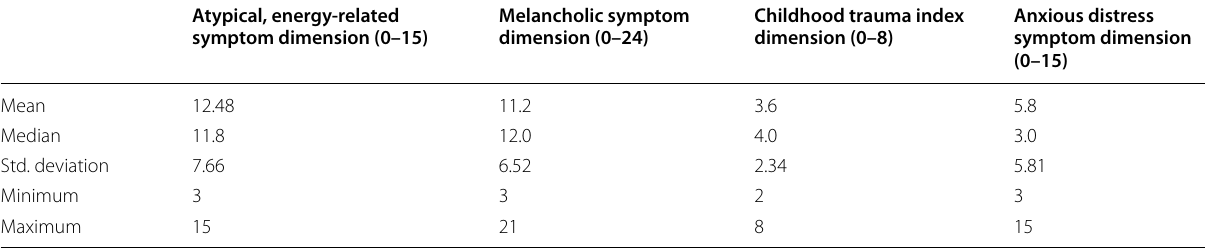
Table 3 Depression dimensional profilers’ score distribution among the cases group